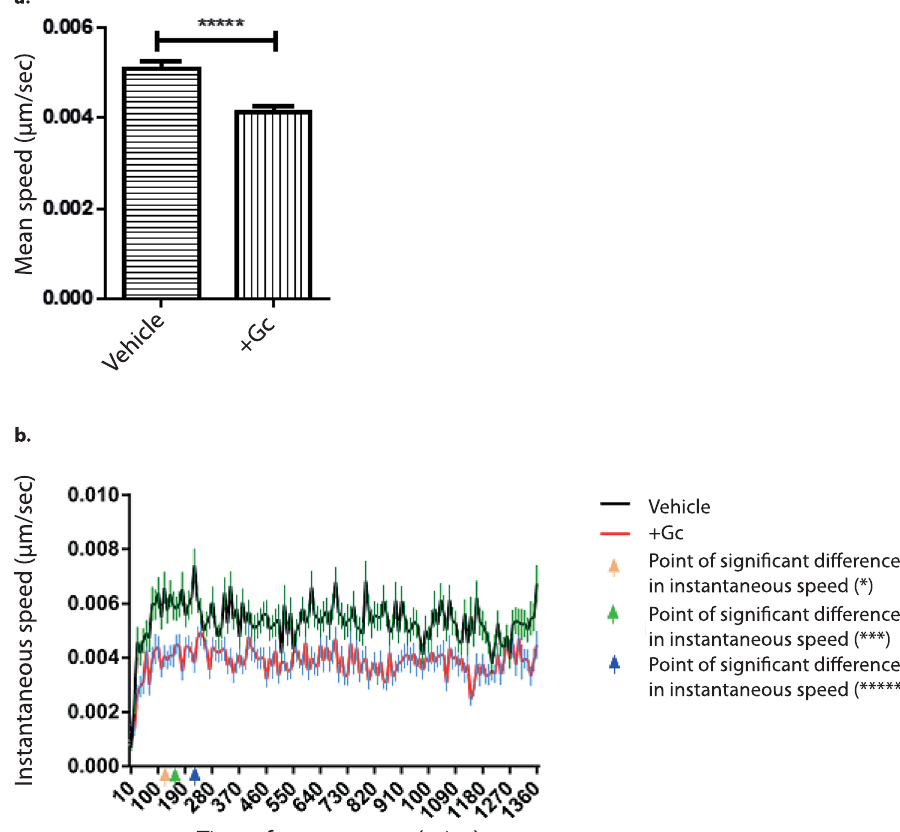
Figure 5. Early effects of Gc on podocyte motility. To analyse the length of time taken for Gc to affect podocyte speed, live cell imaging of wild type podocytes was performed in the 24 hour period following treatment. Each experiment consisted of manually tracking 120 cells per condition using ImageJ software. The experiment was performed twice. ( a ) Shows the mean cell speed during the whole period of imaging. ( b ) Shows the instantaneous speed for the podocytes during the 24 hour period. Coloured arrows on the X-axis refer to the level of significance of the difference between the means of cell speed between vehicle- and Gc-treated cells. The first time of significant difference is shown by the arrow at 120 minutes. Results were analysed by two- way repeated measures ANOVA followed by Šídák’s multiple comparisons test. * = adjusted p value 0.0134; *** = adjusted p value 0.0004; **** = adjusted p value < 0.0001. Error bars represent standard error of the